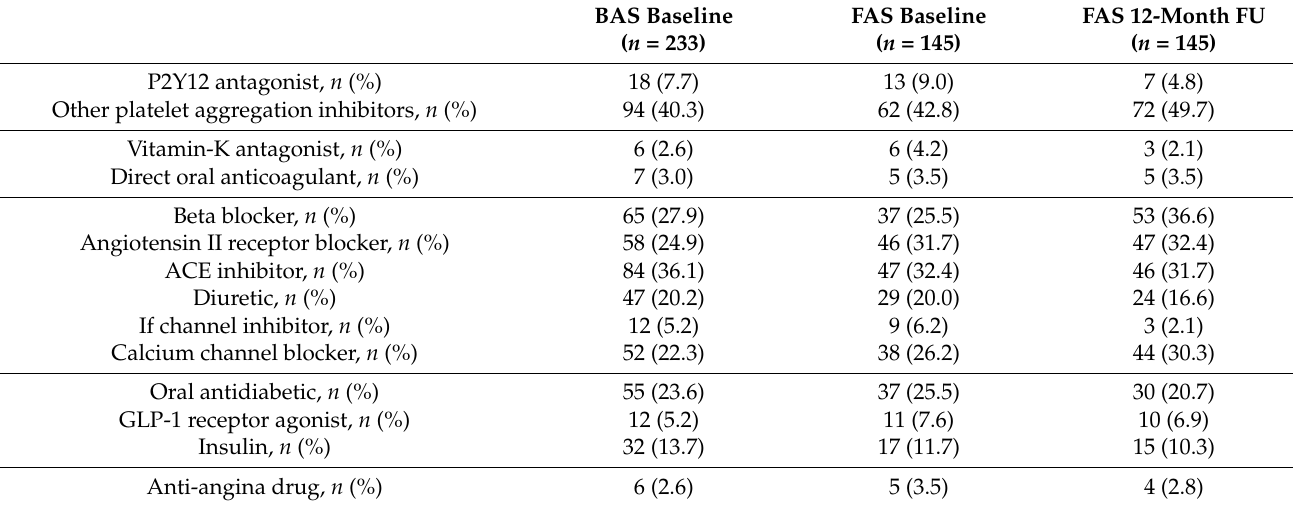
Table 3. Cardiovascular pharmacotherapy in the BAS and